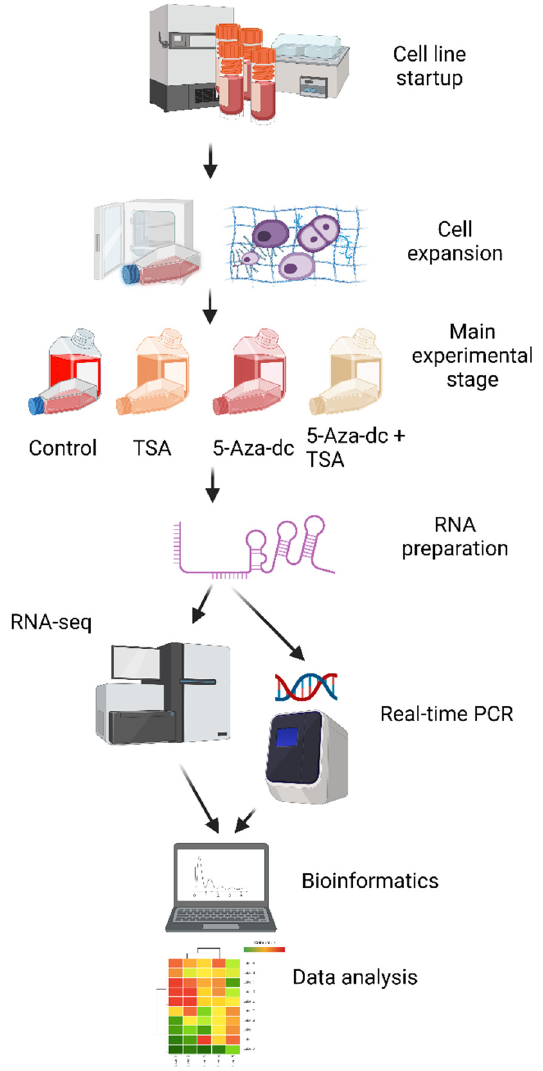
Figure 4. Scheme of the research (created with BioRender.com; license agreement FU24GOX88E ).